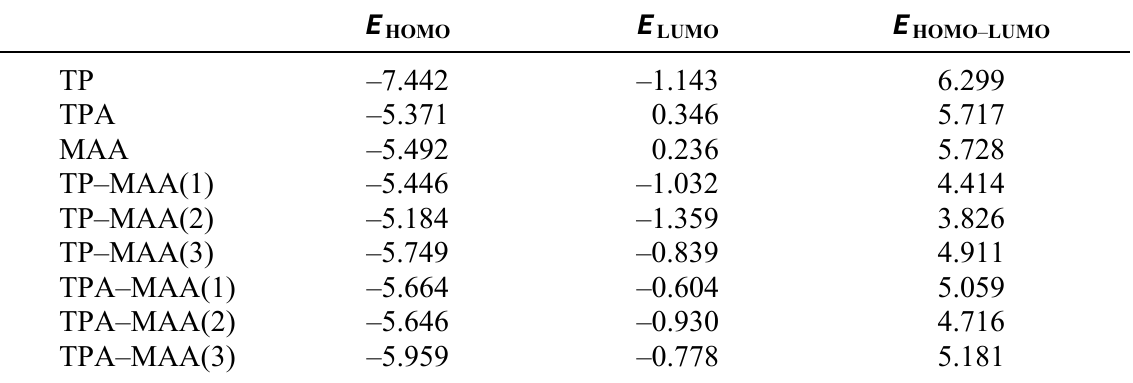
Table 2. Summary of the quantum chemical parameters of template-monomer